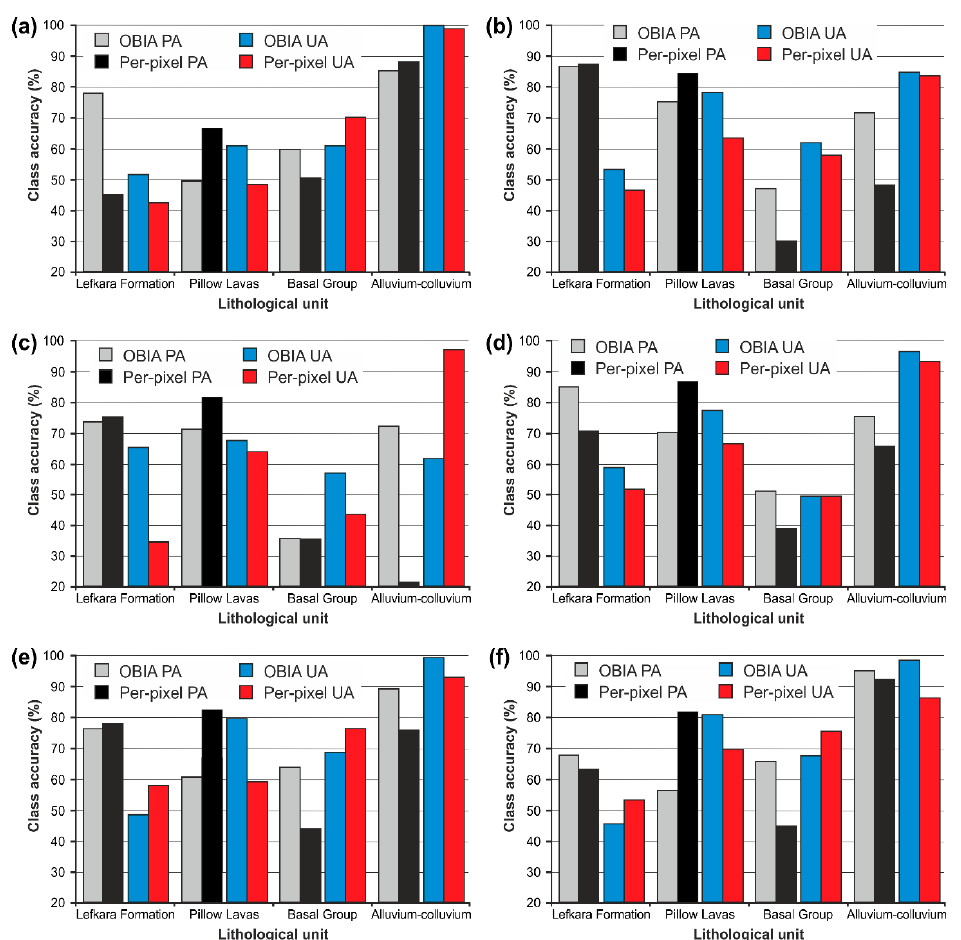
Figure 8. Comparison of the Producer’s (PA) and User’s (UA) accuracies for equivalent OBIA and per-pixel classifications: ( a ) Li; ( b ) ATM 9; ( c ) ATM PC; ( d ) ATM MNF; ( e ) ATM-Li; and ( f ) ATM-Li MNF.